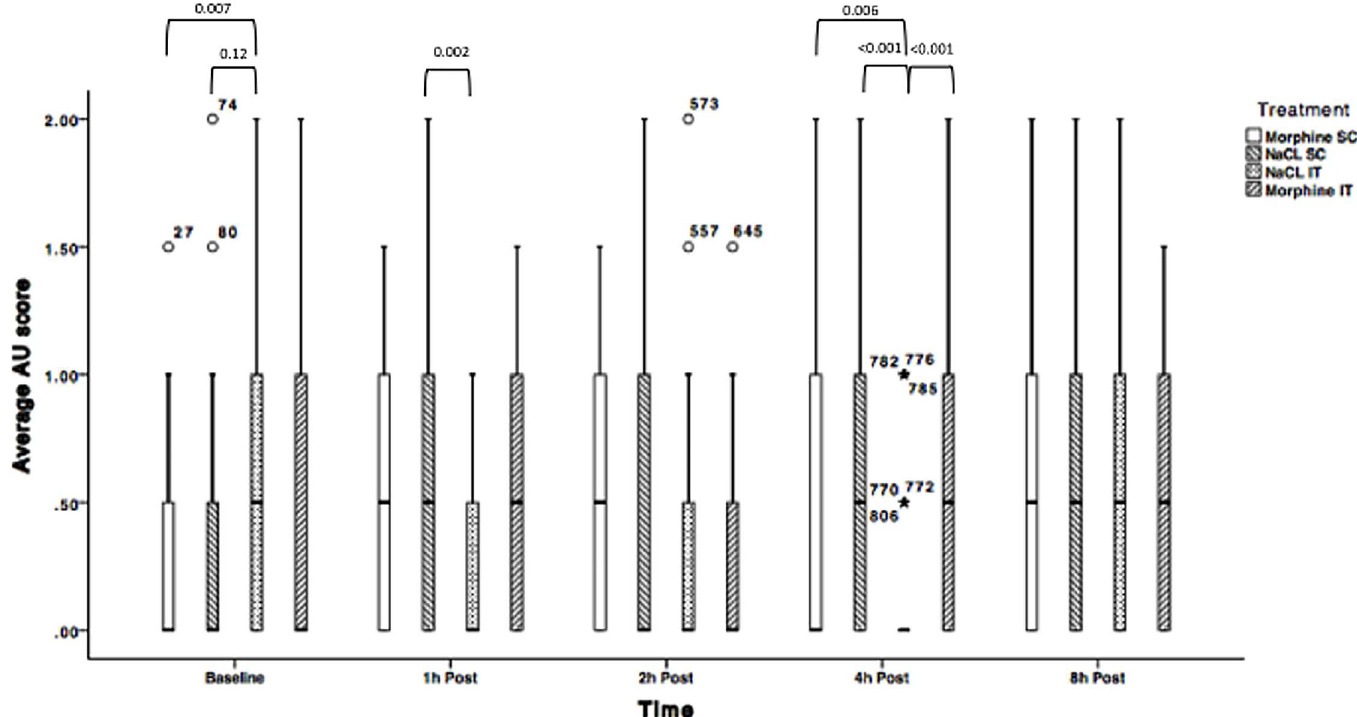
Fig 3. Average Action Unit RGS scores for treatments 1.1 (NaCl SC); 1.2 (NaCl IT); 1.3 (Morphine SC) and 1.4 (morphine IT) over time. N = 24 (Solid line = median, box = 1 st and 3 rd quartiles, whiskers = minimum and maximum, $ , (cid:14) = Outliers). AU: Action Unit. P -values are indicatedwhere differences are significant.